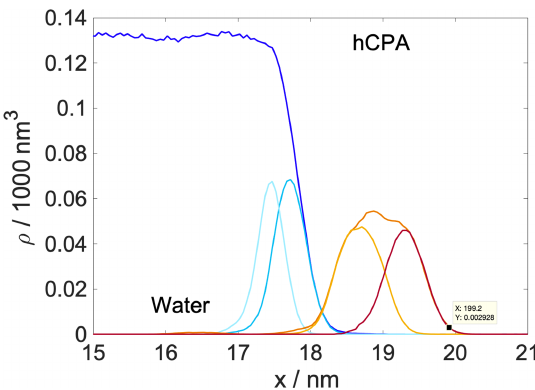
Figure A4. Global number density profiles overlapped with the den- sity profiles of the first two molecular layers detected by the ITIM algorithm. Density profiles are not centered at the center of mass of the aqueous